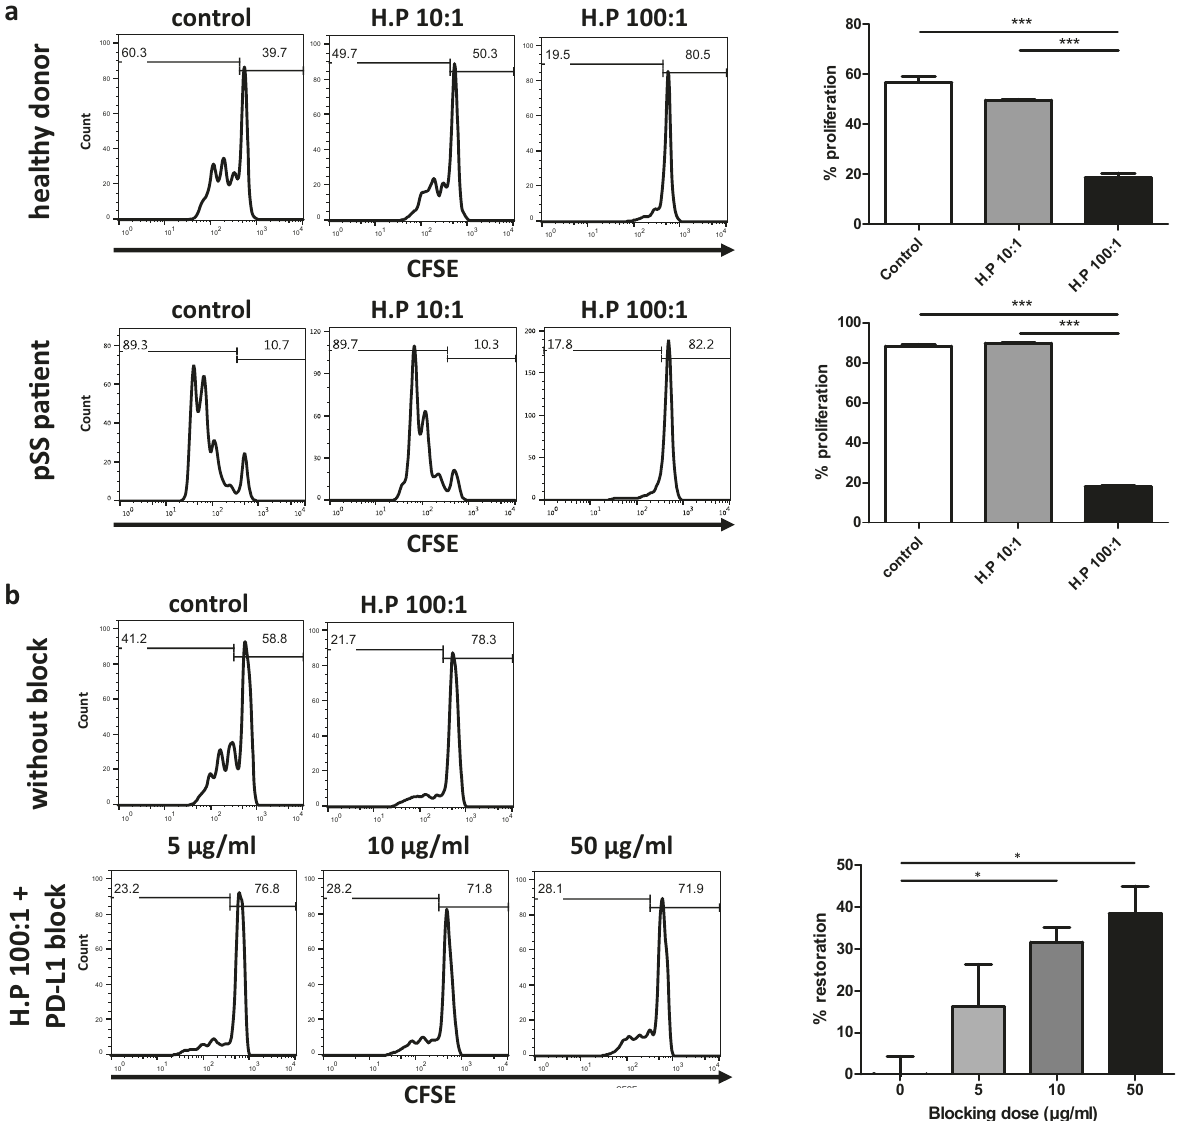
Fig. 5 Inhibition of CD4 T cell proliferation by H. parain fl uenzae -pretreated A253 cells and partial restoration by PD-L1 blockade. a CD4 T cell were coculture with H. parain fl uenzae -pretreated A253 cells at various bacteria-to-cell ratios. CD4 T cells were isolated from peripheral blood mononuclear cells of healthy donors and anti-Ro-positive pSS patients. One-way ANOVA, p < 0.001; post hoc analysis, *** p < 0.001. b CD4 T cells isolated from healthy donors were cocultured with H. parain fl uenzae -pretreated A253 cells at a bacteria-to-cell ratio of 100:1 and PD-L1 blocking antibody was added at various dosages. One-way ANOVA, p = 0.014; post hoc analysis, * p < 0.05. Error bars stand for one standard